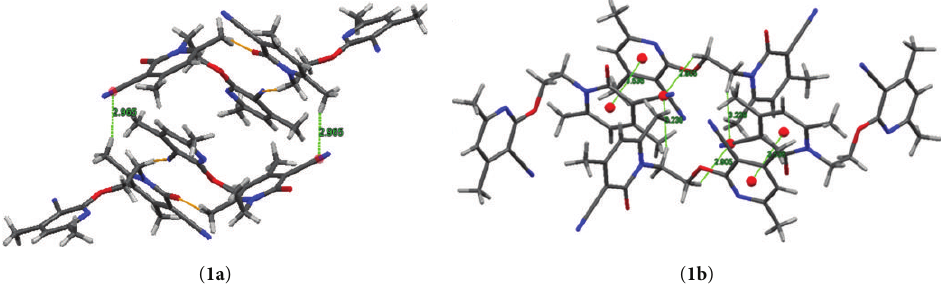
Figure 3: Packing of crystal shows its geometry and interactions in ( 1a ) and ( 1b ) polymorph.